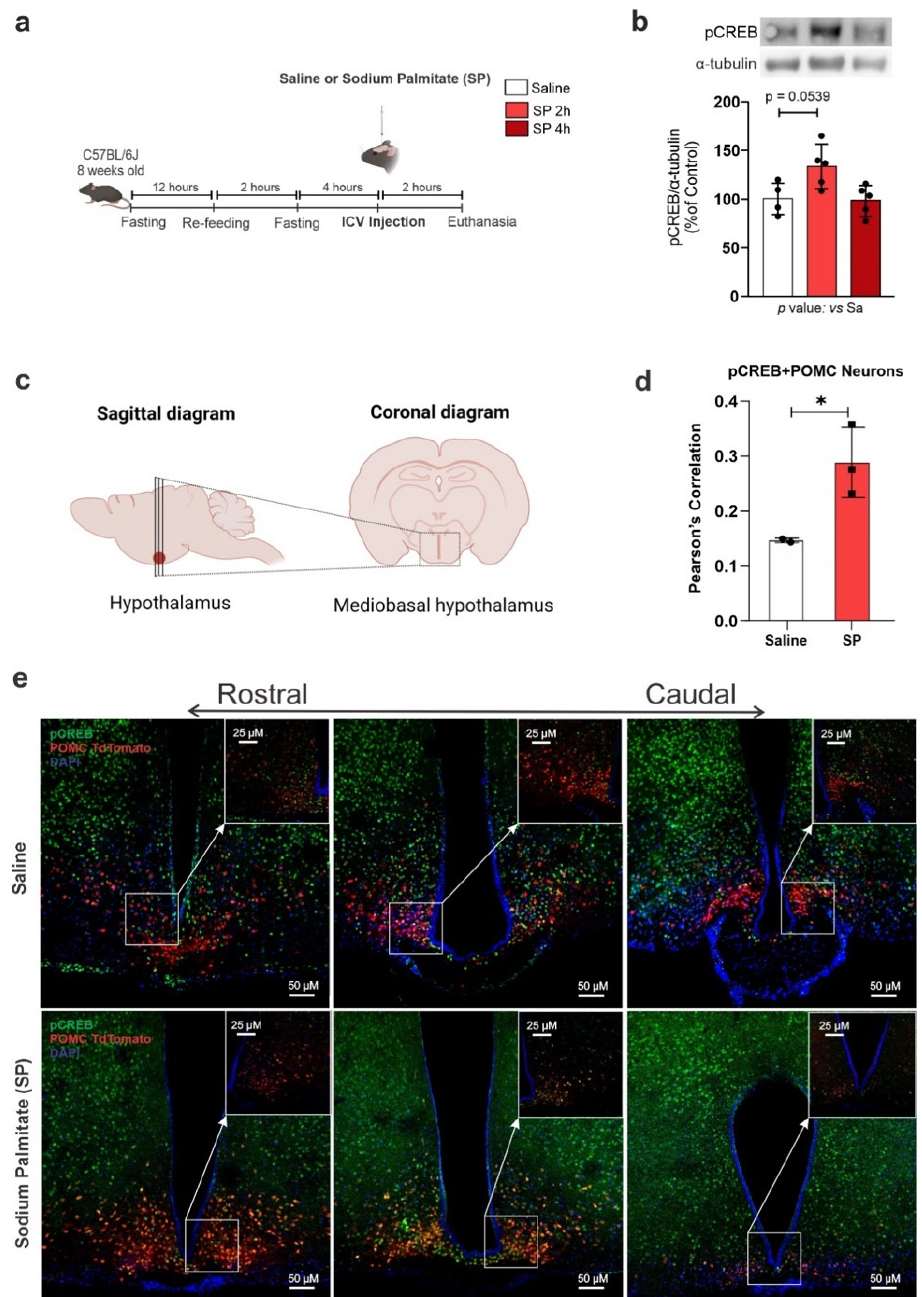
Figure 5. Palmitic acid modulates hypothalamic CREB expression specifically in Pomc neurons. Adult male C57BL/6 and Pomc tdTomato mice were submitted to an ICV injection of saline or 30 µM sodium palmitate (SP) and the hypothalamus was collected at different time points after injection. ( a ) Schematic representation of the experimental protocol; ( b ) Western blotting of the hypothalamus; ( c ) schematic representation of stereological protocol; ( d ) quantification of double-labeling neurons; ( e ) coronal brain sections of the mediobasal hypothalamus were immunostained with pCREB; the arrows indicate higher magnification of the selected region. For Western blotting, data are presented as means ± SD. N = 4–5 per group. ANOVA followed by Tukey’s post hoc test was used for statistical analyses. * p ≤ 0.05 in comparison with the saline group. For immunostaining data are presented as means ± SD. N = 2–3. Pearson’s correlation followed by Costes correlation was used for statistical analyses. * p ≤ 0.05 in comparison with the saline group.